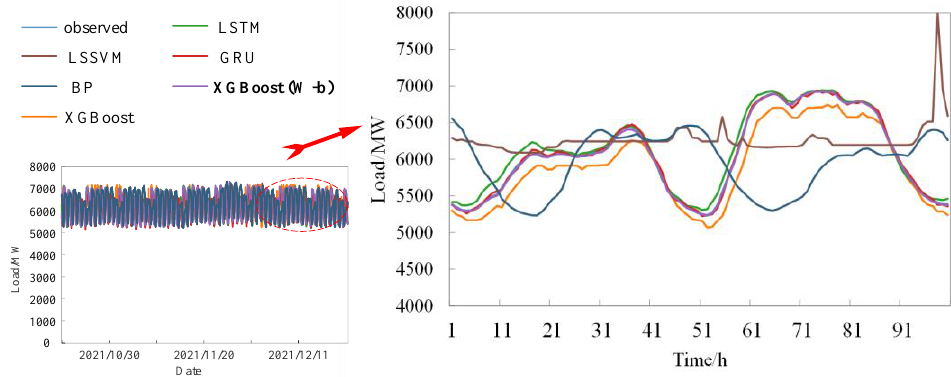
Figure 5. Load forecasting considering real-time electricity prices. Table 6. The experimental error of each model (considering the real-time electricity price).